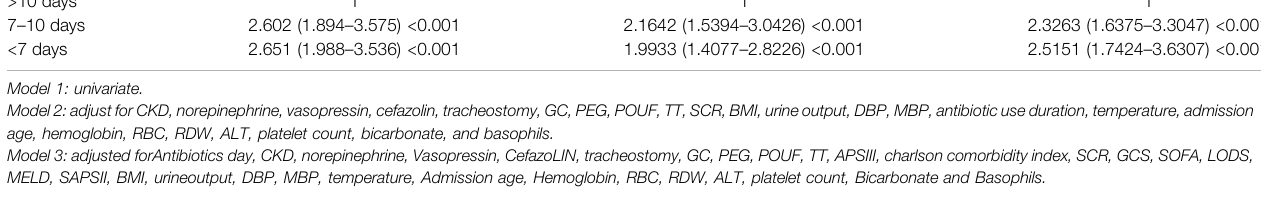
TABLE 3 | Cox regression analyses of the relationship between the duration of antibiotic use and VAP prognosis. Variable Model1